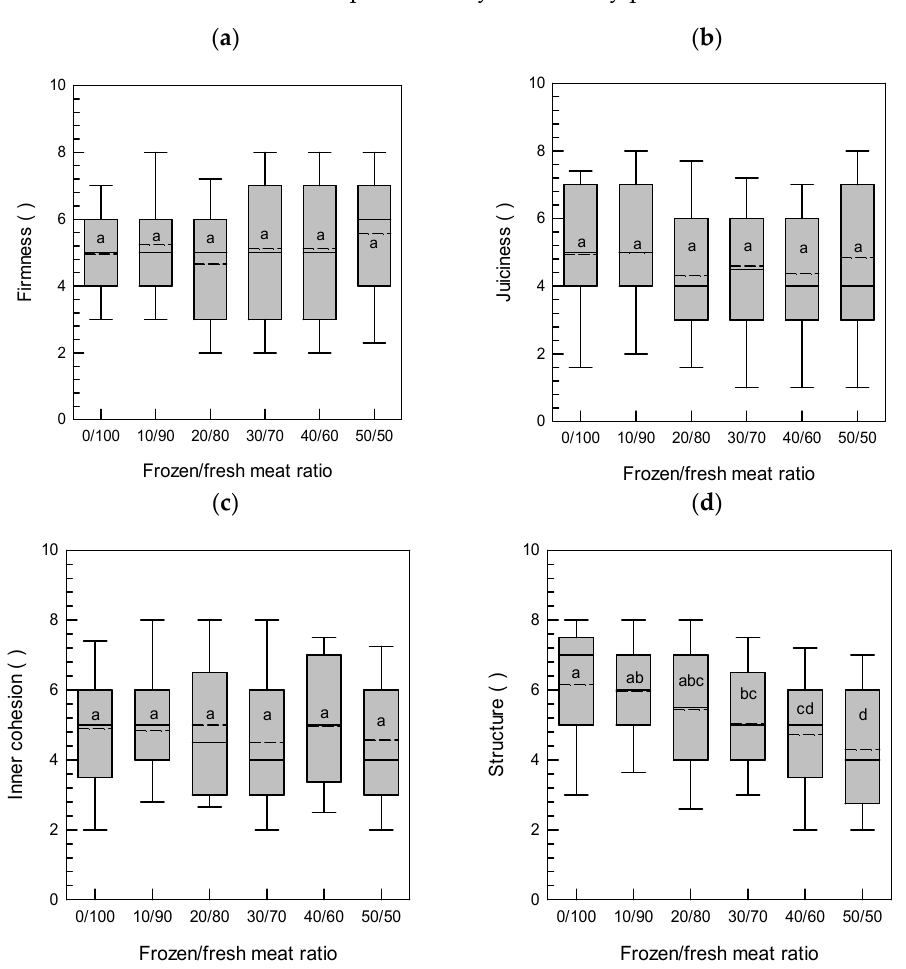
Figure 4. Boxplots of sensory evaluation of ( a ) firmness, ( b ) juiciness, ( c ) inner cohesion, and ( d ) inner structure (n = 96) of cooked meatballs consisting of varying frozen to fresh meat ratios; 0 means soft, dry, loose cohesion, and fine structure, whereas 10 means firm, juicy, strong cohesion, and coarse inner structure. Dotted line marks mean, full line marks median, box marks lower and upper quartile, and whiskers mark distance until lower and upper extreme. Different letters represent significant differences ( p < 0.05) for each parameter.